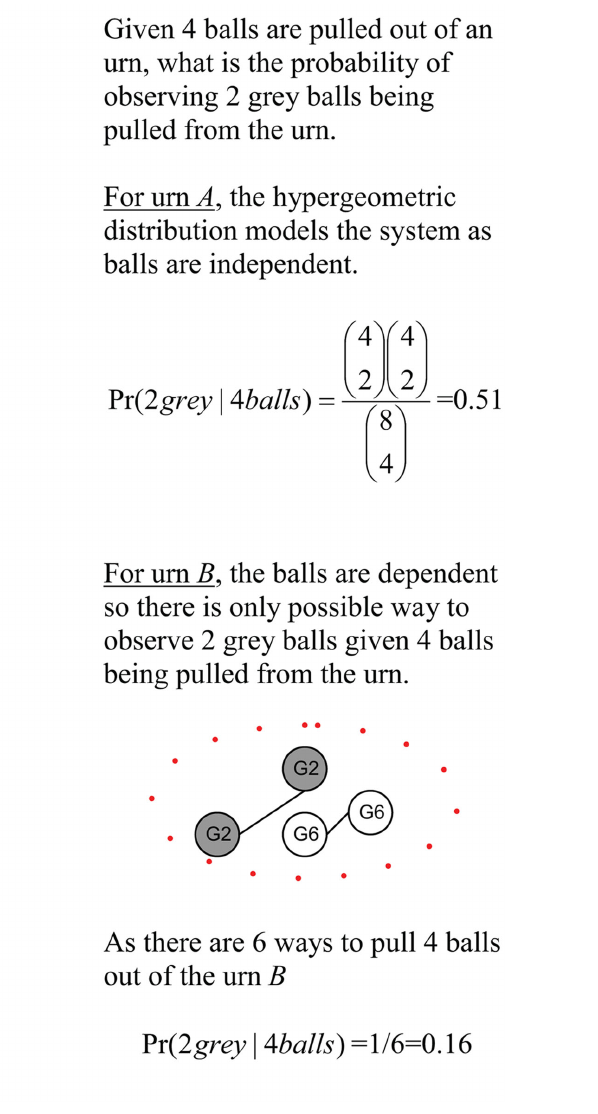
FIGURE 2 | Urn representation of Figure 1 diagram illustrating the principles of independent versus interrelated models. Gray balls (genes) are those found at or below v 4 and white balls (white) are those found in the